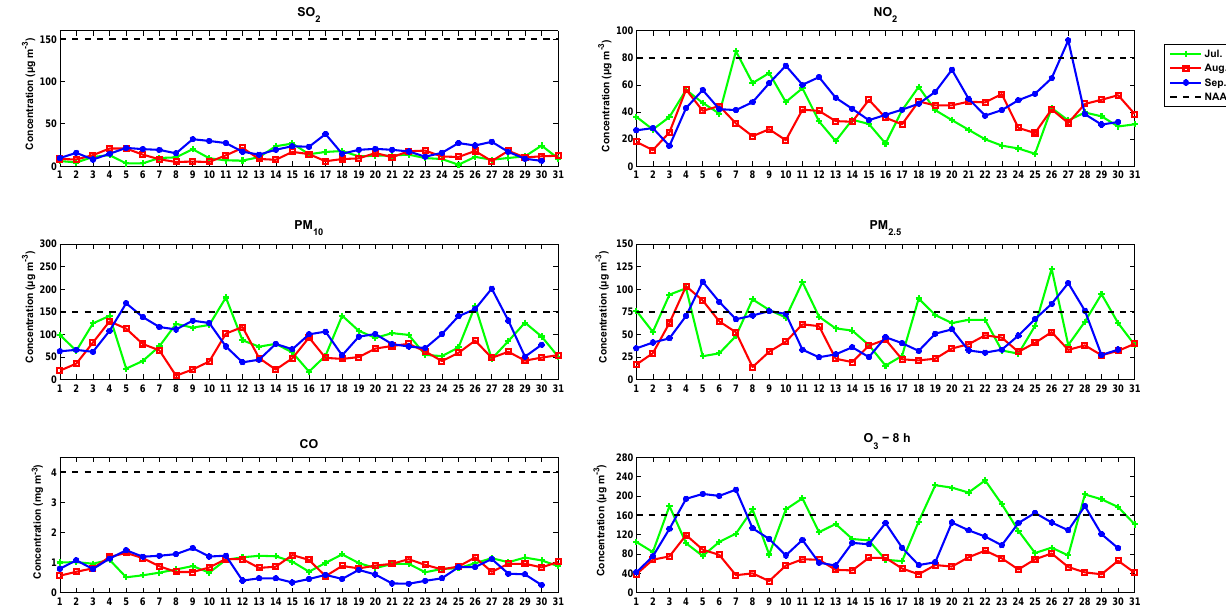
Figure 5. Day-to-day variations in SO 2 , NO 2 , PM 10 , PM 2 . 5 , CO and O 3 -8h at CCM station in July, August and September 2014 (CST). Observed data for July, August and September 2014 are indicated in green, red and blue respectively. NAAQS are indicated with a black dotted line.